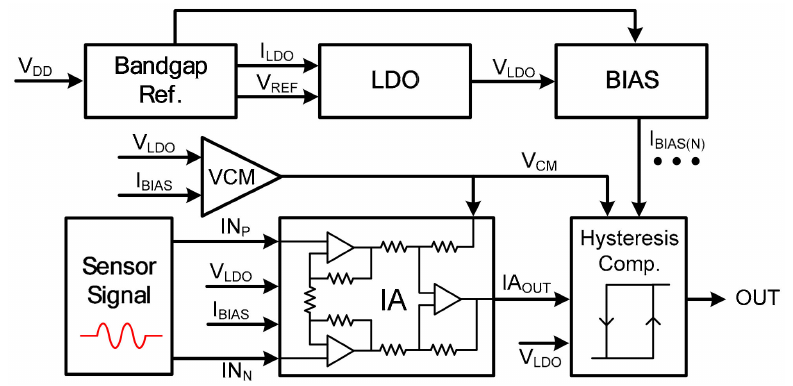
Figure 2. Block diagram of the entire IA system.